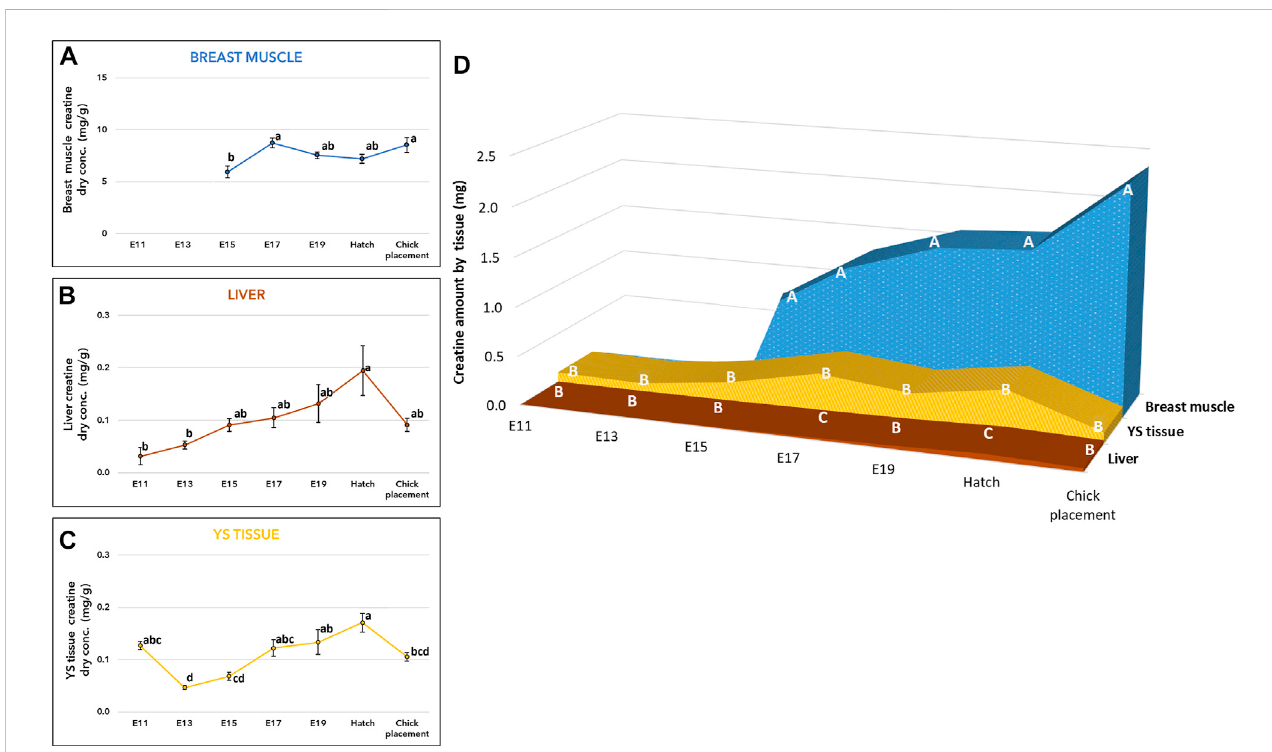
FIGURE 1 Creatine levels from E11 until hatch and at chick placement (A – C) Dry weight concentration (mg/g) and (D) total tissue amount (mg) of Yolk sac (YS) tissue, liver, and breast muscle (A – C) The lower-case letters denote for means signi fi cantly different between days within each organ, as derived from a one- way ANOVA Tukey ’ s HSD test (D) The capital letters denote for means signi fi cantly different between organs within each day as derived from a two-way ANOVA followed by Tukey ’ s HSD test. p ≤ 0.05 n = 6 per